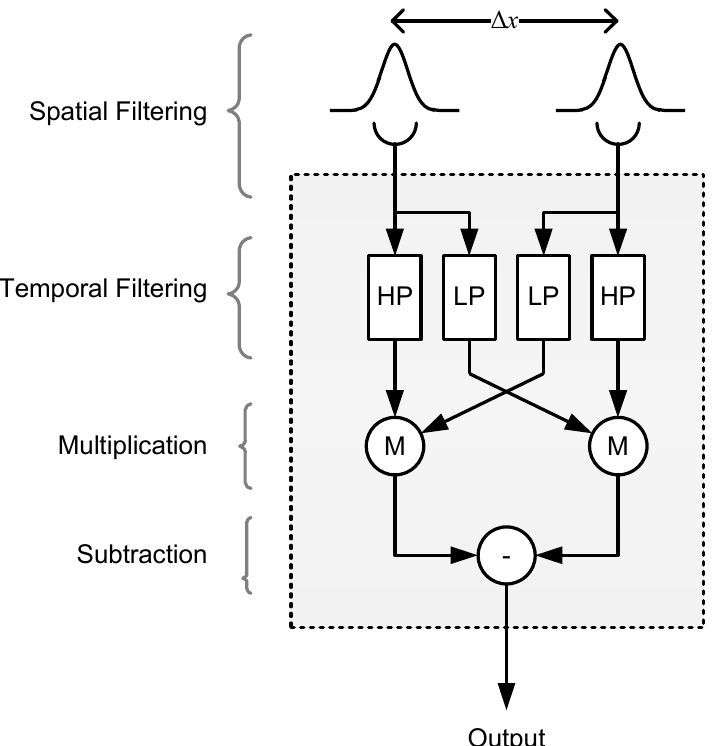
Figure 8. The Reichardt Detector. The spatial input from two identical Gaussian filters (standard deviation σ ) separated by ∆ x is passed through high and low pass temporal filters (HP and LP, respectively). The LP output in each subunit is cross-correlated with the HP output from the other subunit using a multiplication stage (M), and the two products are then subtracted to produce a direction-sensitive measure of motion. In the RD-based Model 2 (Figure 9), the spatial filter parameters are σ 1 = 1.07 ◦ , ∆ x 1 = 1.0 ◦ for detector class 1, and σ 2 = 3.42 ◦ , ∆ x 2 = 2.5 ◦ for detector class 2, while the low and high pass filter time constants are τ L = 13 ms, τ H = 40 ms,